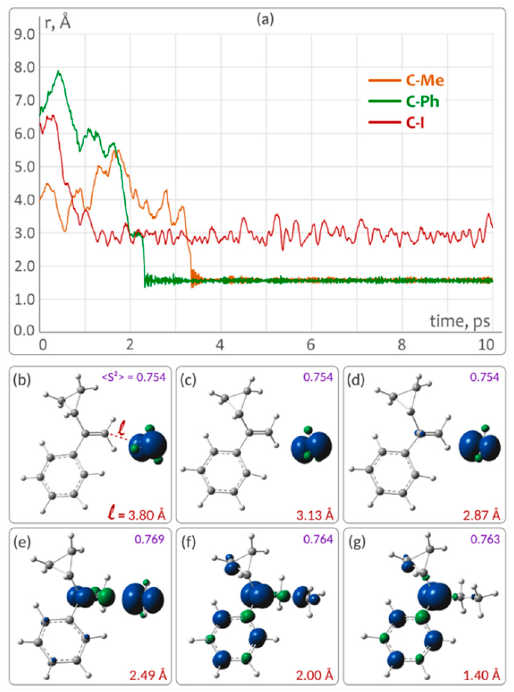
Figure 2. ( a ) Dynamics of the C-C Me , C-C Ph , and C-I interatomic distances for the interaction processes of the methyl radical, phenyl radical, and iodine radical with compound 1 ; ( b – g ) some MD-trajectory frames of the spin density dynamics for the addition of Alk • radical to compound 1 (the C-C interatomic distance between radical carbon atom and terminal carbon atom of alkene are shown in red for each structure; the values of the <S 2 > are shown in purple for each structure).